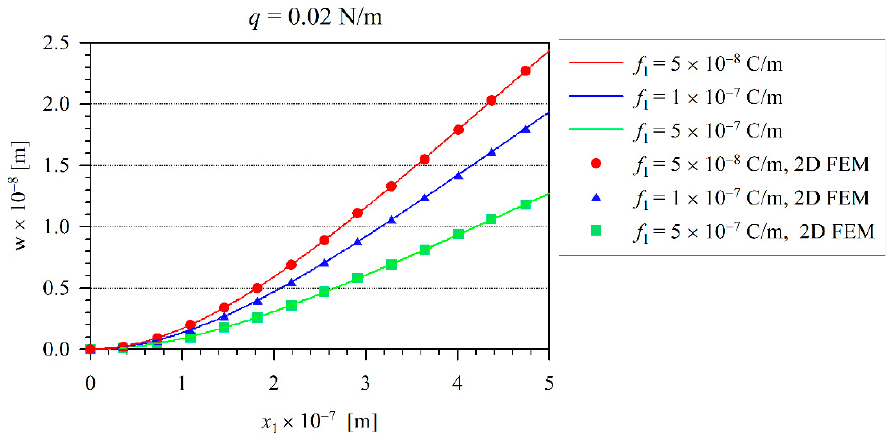
Figure 2. The variation of the deflection of the beam for various flexoelectric coefficients.